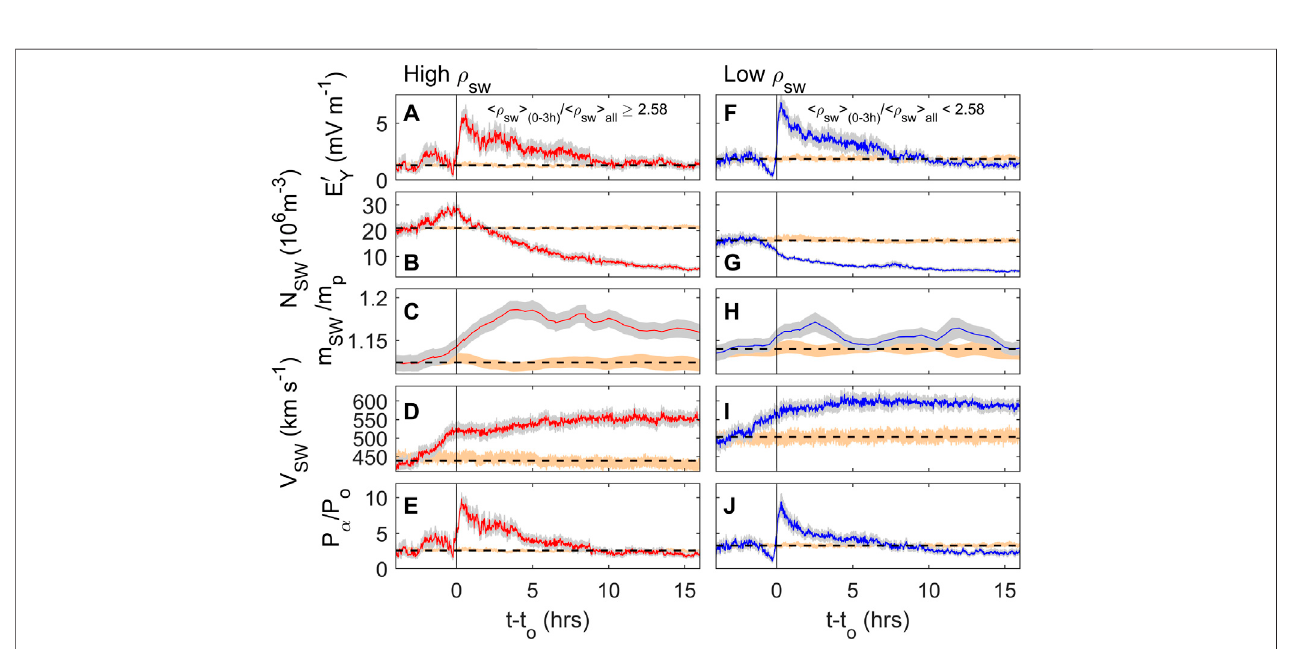
FIGURE 13 | The same as Figure 11 but with the 160 southward turning events sorted by the solar wind mass density, ρ SW as in Figure 12 .